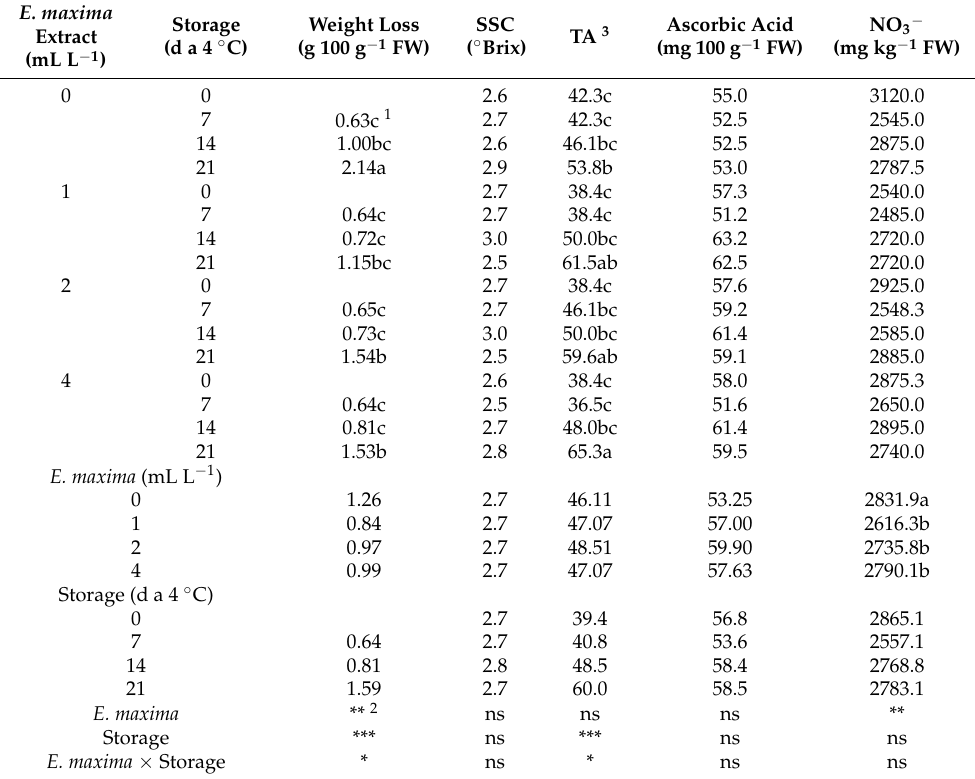
Table 3. Effect of different concentrations of Ecklonia maxima extract in the nutrient solution and cold storage on weight loss, soluble solids content (SSC), titratable acidity (TA), ascorbic acid and nitrate (NO 3 − ) content of fresh-cut leaf